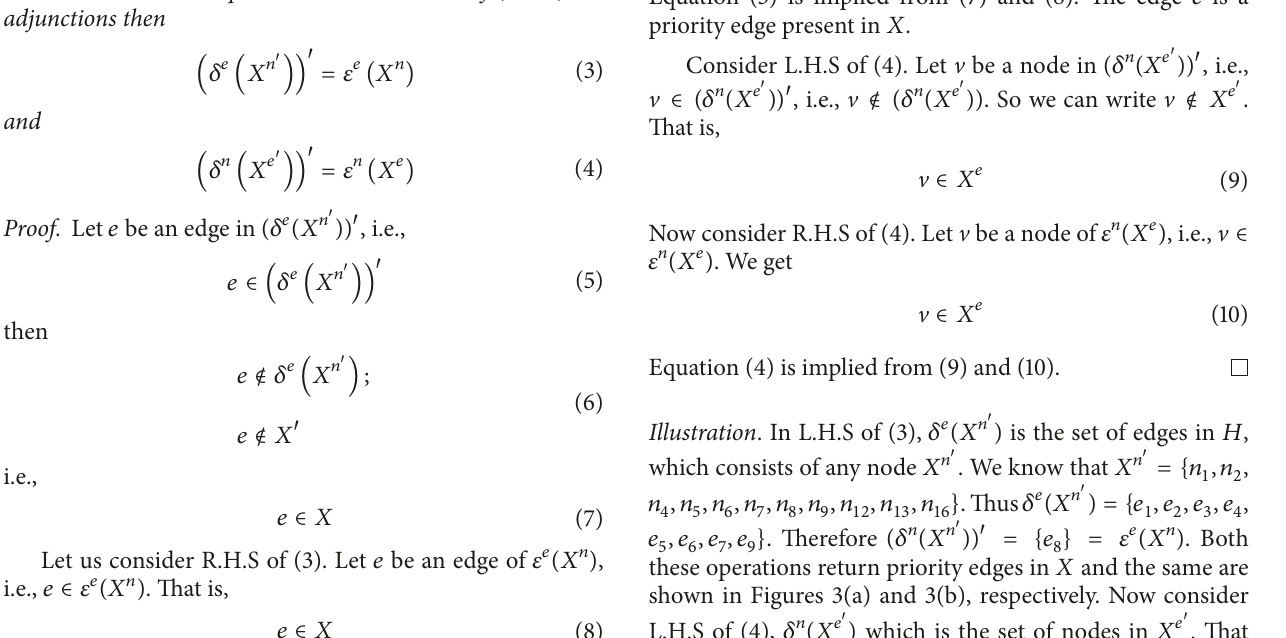
Figure 3: Complement results of adjunction (a) (𝛿 𝑒 (𝑋 𝑛 𝜀 𝑒 (𝑋 𝑛 )